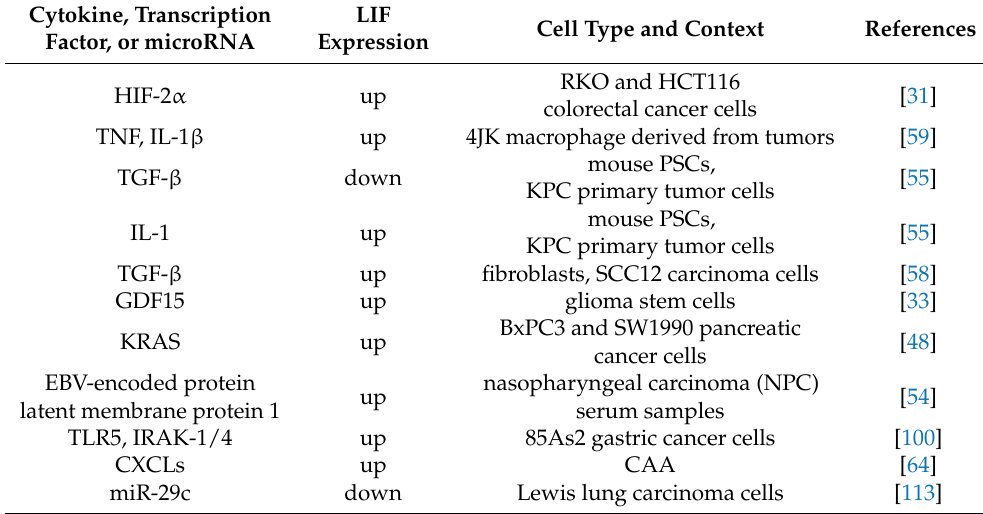
Table 1. Transcriptional regulation of the LIF